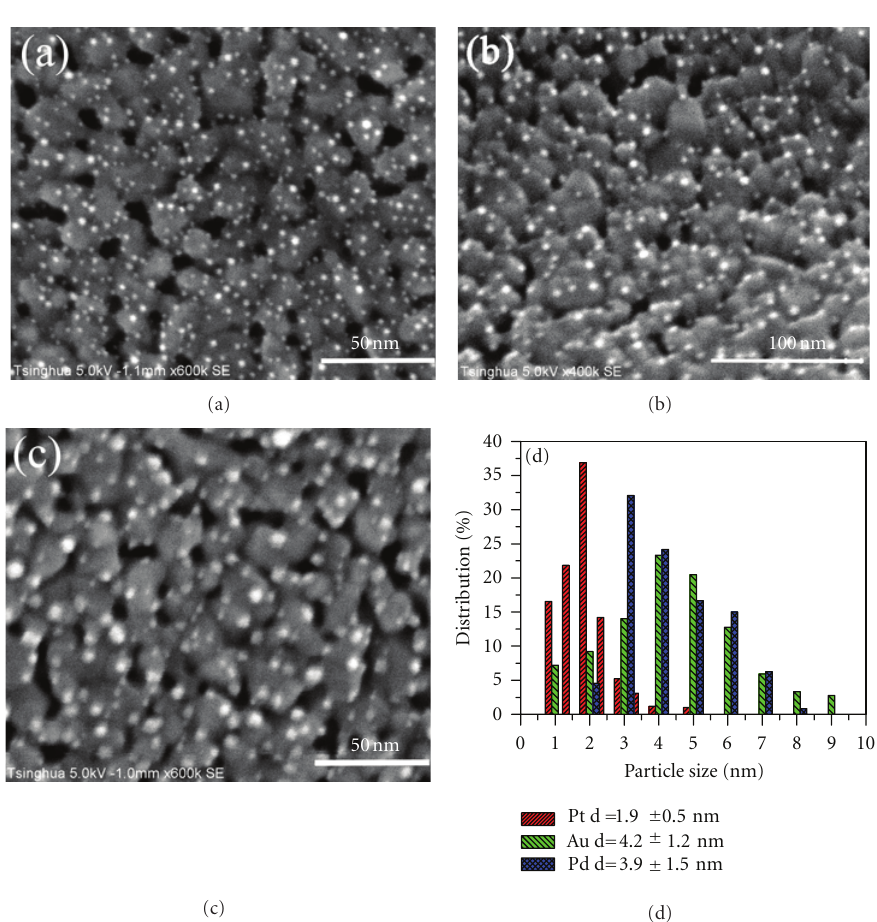
Figure 1: FESEM images of deposited Pt (a), Au (b), and Pd (c) nanoparticles on TiO 2 films. (d) The size distribution histogram of deposited Pt, Au, and Pd